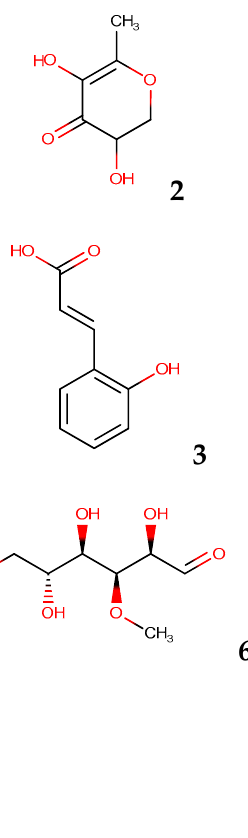
Figure 4. Structures of the compounds.